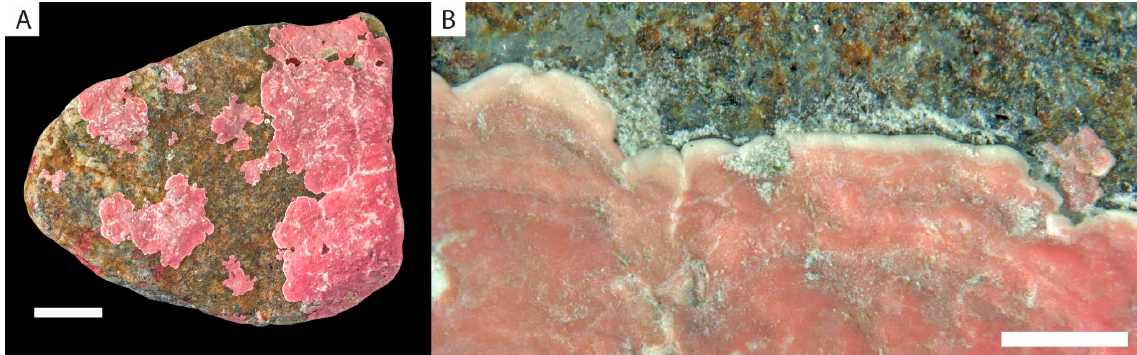
Figure 1. Overview of specimen Ross-7 with several individuals of T. antarcticum ( A ) and detail of the growing margins of two individuals ( B ). Scale bars = 1 cm.